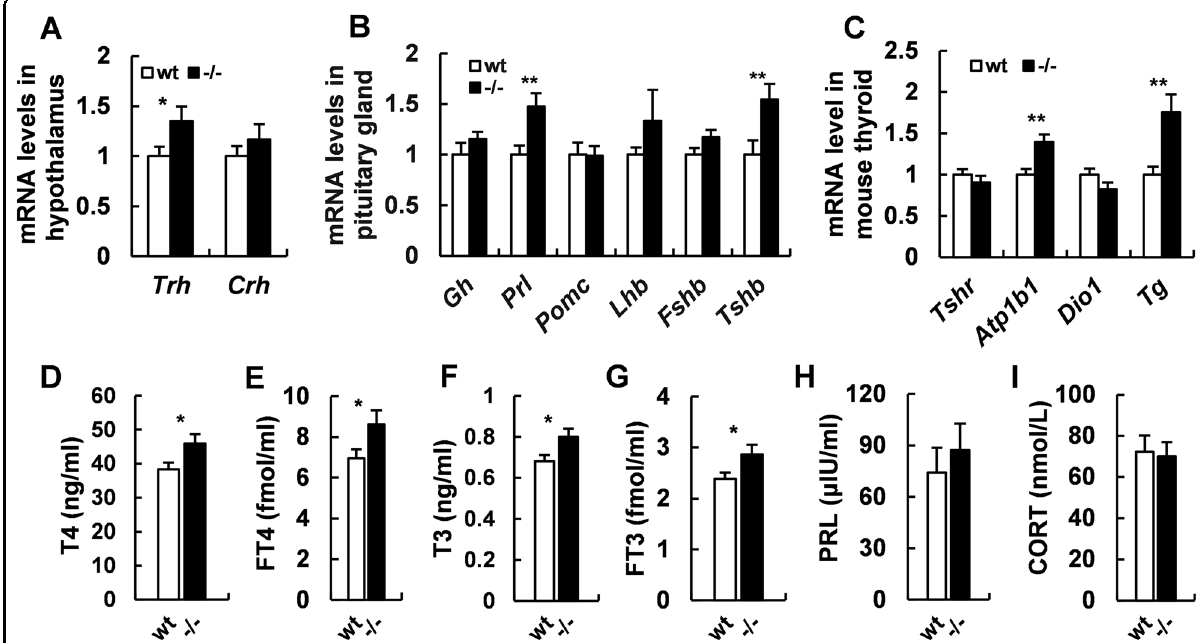
Fig. 6 Adgra1 − / − male mice exhibit mild hyperthyroidism. A mRNA levels of Crh and Trh in hypothalamus of male mice assessed by real-time PCR, n = 5/group. B mRNA levels of trophic hormones in pituitary gland of male mice assessed by real-time PCR, n = 5/group. C mRNA levels of thyroid hormones-related genes in thyroid of male mice assessed by real-time PCR, n = 5/group. D – I Serum hormones levels of Adgra1 − / − male and control mice. D T4 levels, n = 14/group. E Free T4 levels, n = 7 – 9/group. F T3 levels, n = 12/group. G Free T3 levels, n = 7 – 9/group. H PRL levels, n = 4/group. I Corticosterone levels, n = 13 – 14/group. * p < 0.05, ** p < 0.01 vs. controls. Data represent mean ±